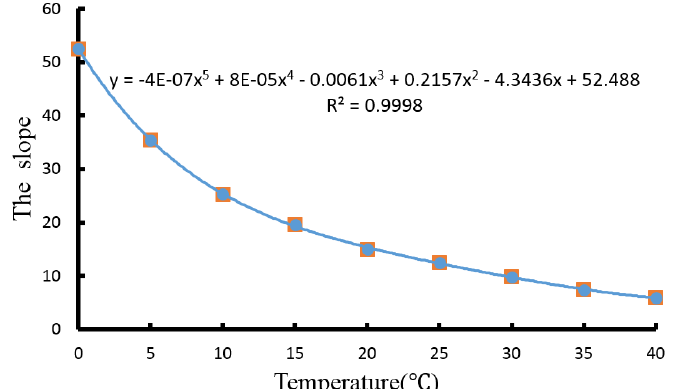
Figure 6. Fitting curve of the slope.